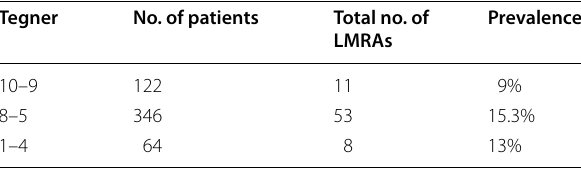
Table 5 Prevalence of LMRA in terms of Tegner score Tegner